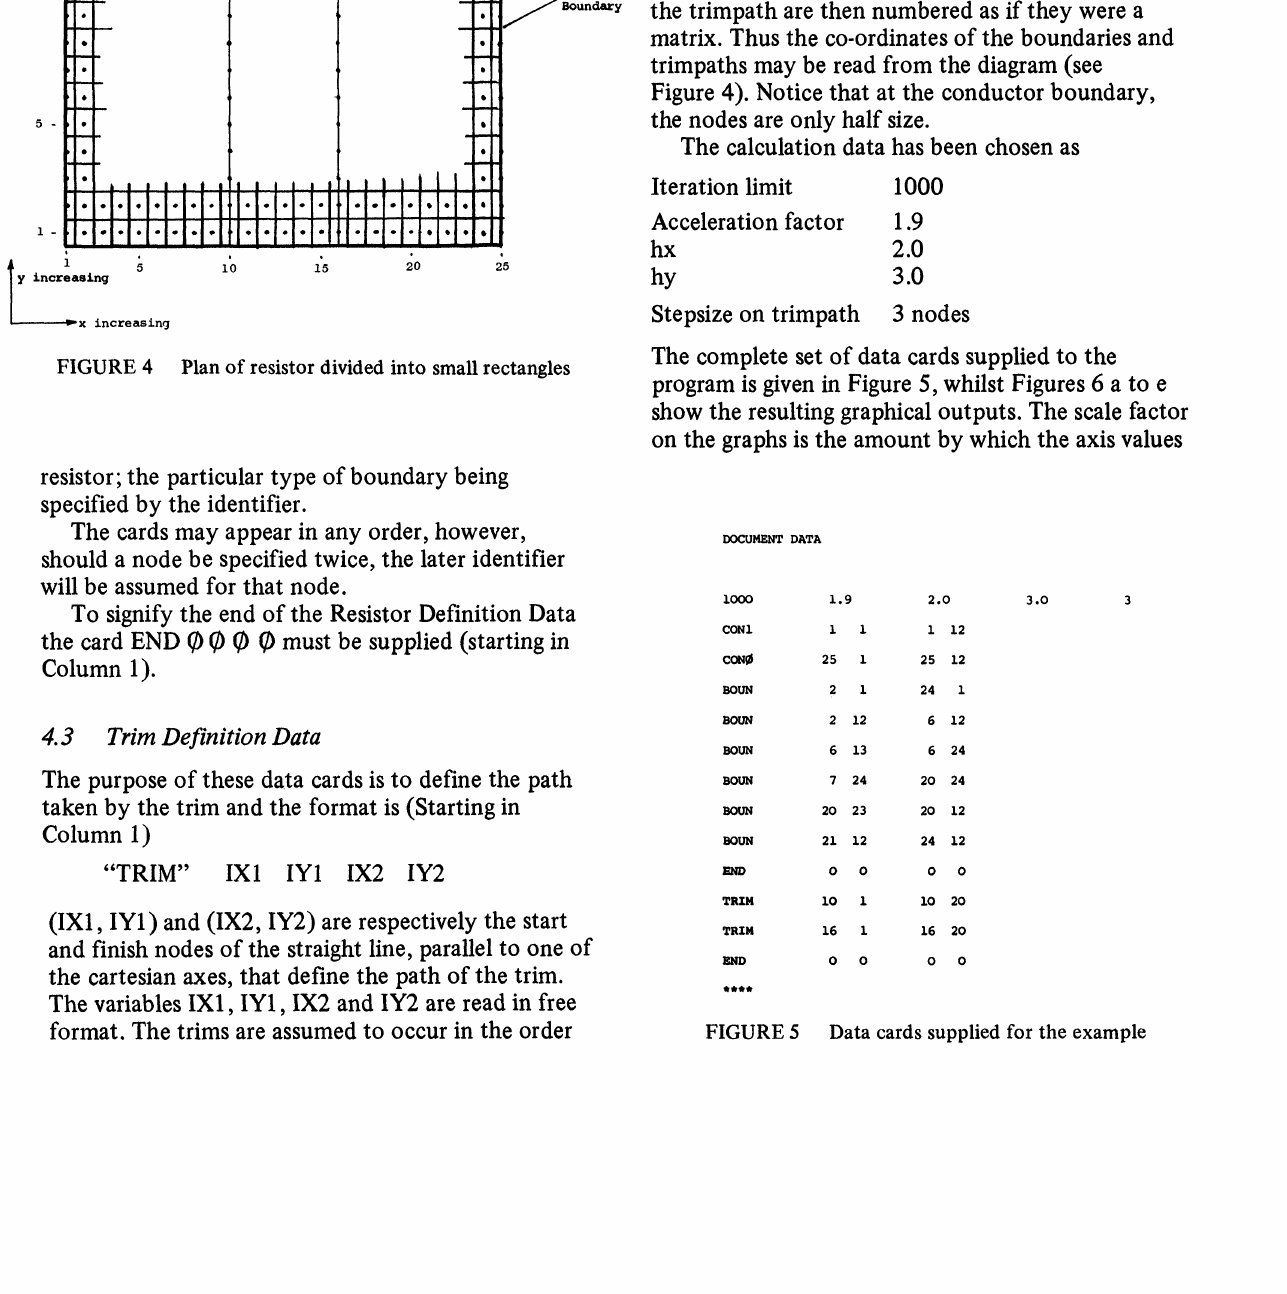
FIGURE 4 Plan of resistor divided into small rectangles